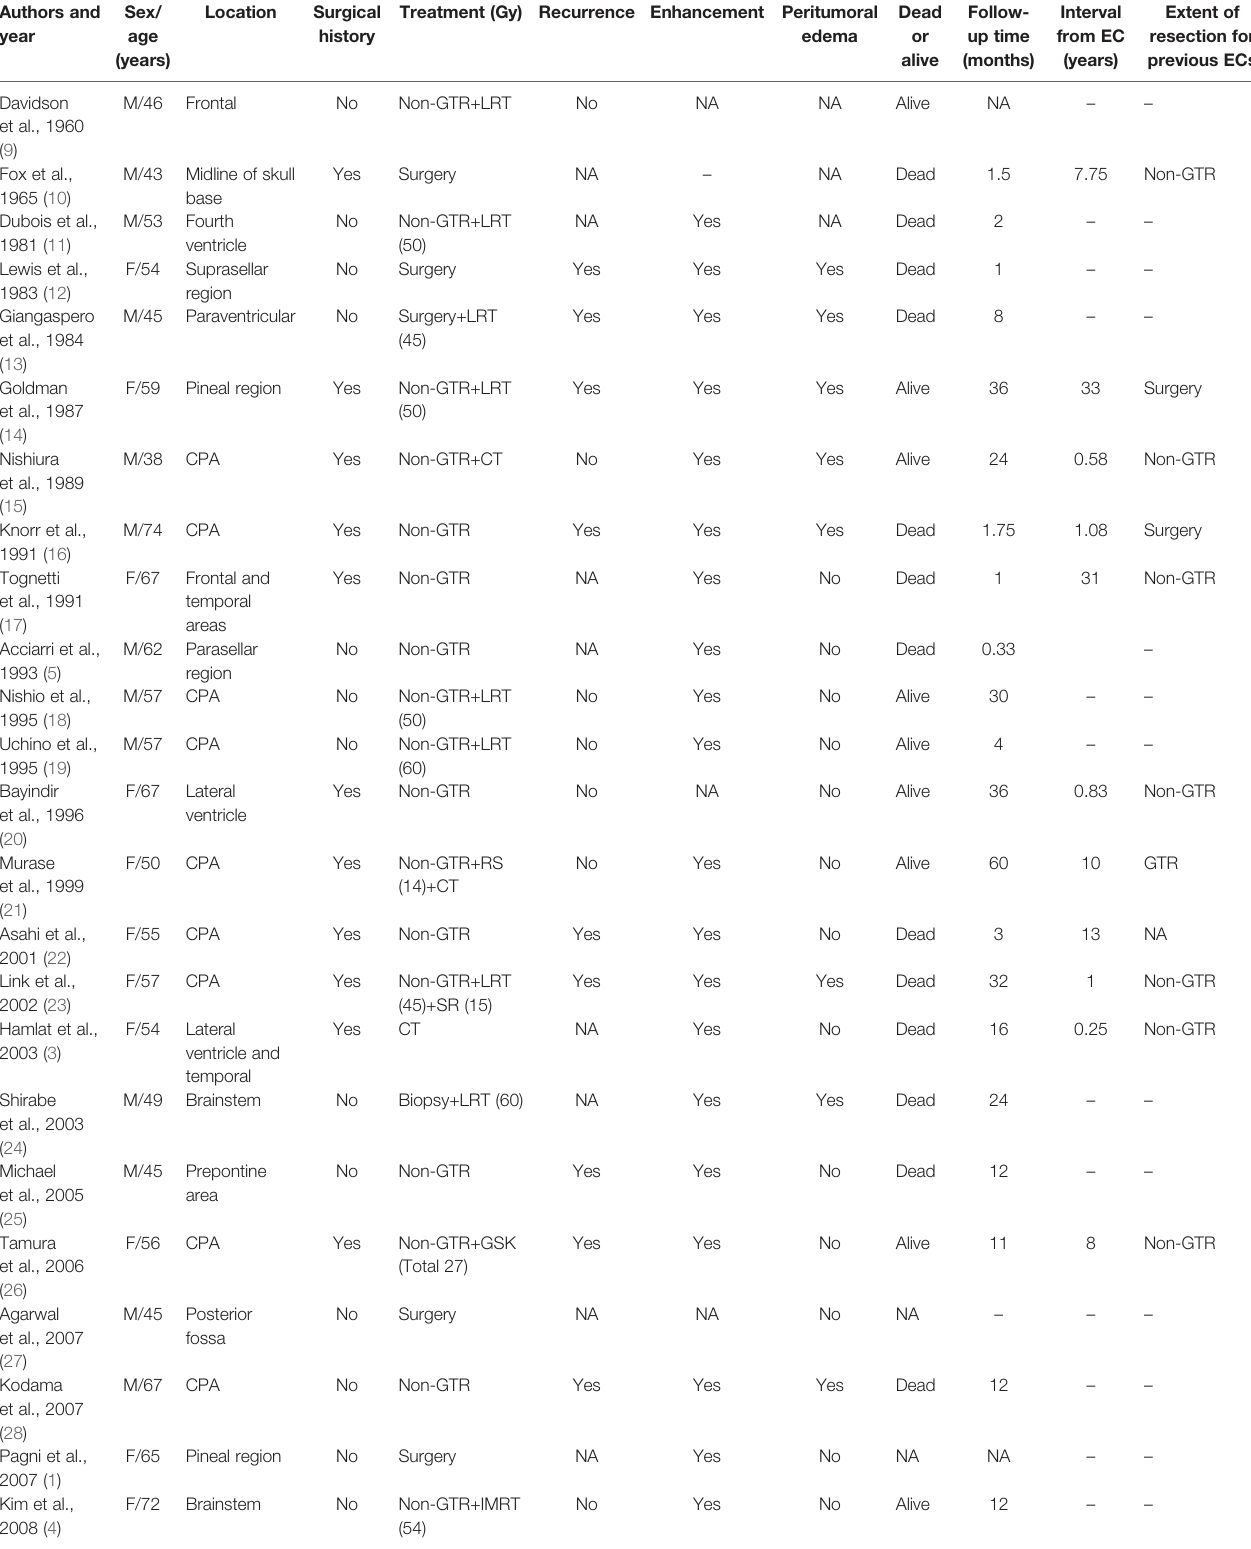
TABLE 2 | Literature review of PSCCs arising in IECs studies from 1960 to 2020. Authors and